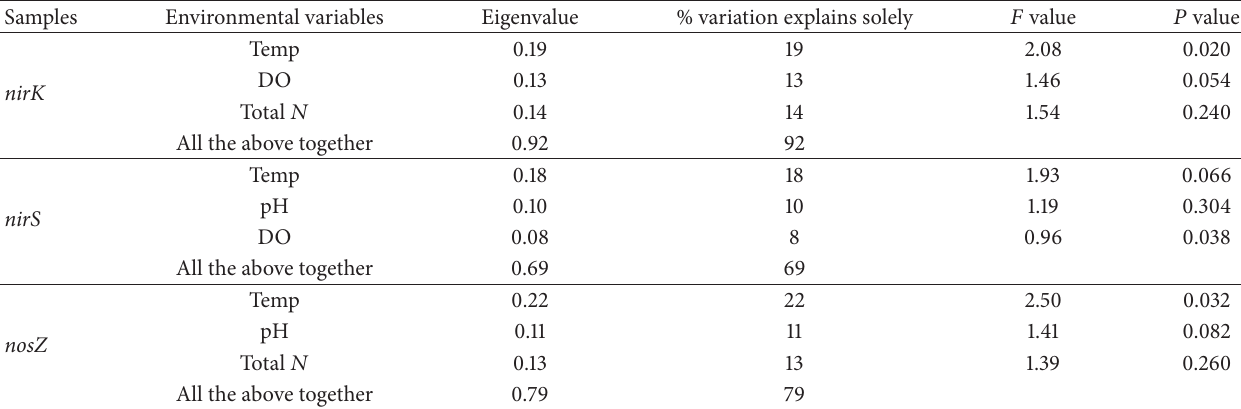
Table 5: Eigenvalues, 𝐹 values, and 𝑃 values obtained from the partial RDAs testing the influence of the significant water properties on the denitrifying bacterial community